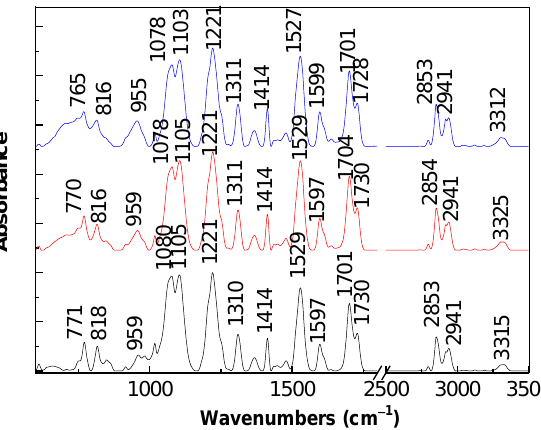
Figure 5. IR spectra of TPU ( a, black curve) and TPU–TiO 2 NW composites, which have TiO 2 NW concentrations equal to 2 wt.% ( b , red curve) and 17 wt.% ( c , blue